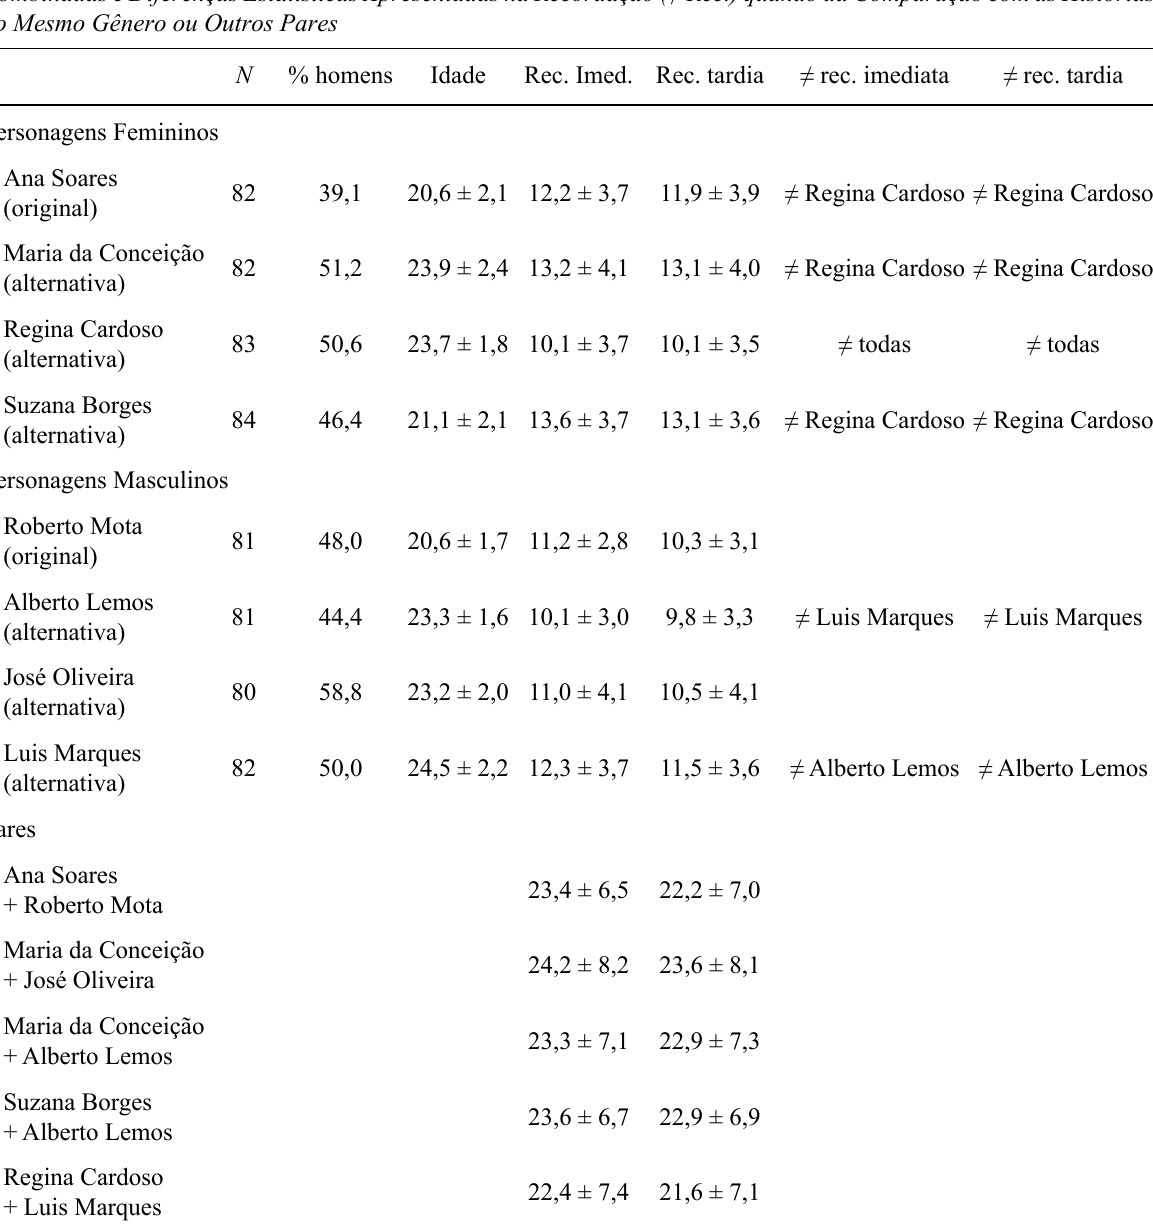
Características Demográ fi cas da Amostra por Versão da História Apresentada (original e alternativa), Média ± Desvio Padrão da Recordação Livre Imediata (Rec. Imed.) e Tardia (Rec. Tardia) de cada História e de Pares destas Versões Combinadas e Diferenças Estatísticas Apresentadas na Recordação ( ≠ Rec.) quando da Comparação com as Histórias do Mesmo Gênero ou Outros